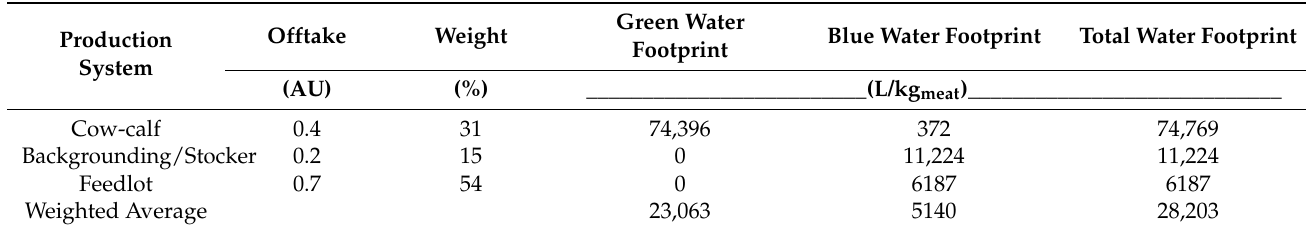
Table 4. Annual average beef water footprint (L/kg meat ) for New Mexico beef cattle production system for the different operation